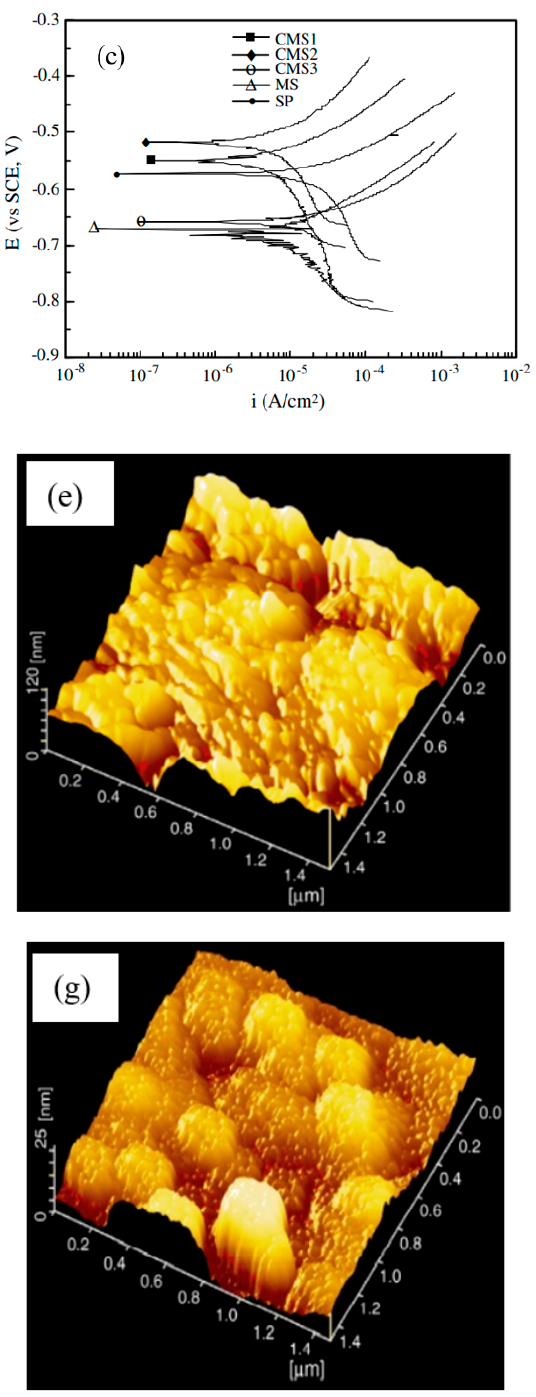
Figure 7. Surface morphology of the sol–gel-coated specimens sintered at ( a ) 400 °C and ( b ) 500 °C [71]. ( c ) PDP plots for the mild steel (MS), the surface pre-treated mild steel (SP) and the sol–gel-coated specimens sintered at 300 °C (CMS1), 400 °C (CMS2) and 500 °C (CMS3) in 3.5% NaCl solution at room temperature [71]. AFM micrographs of coated surface: ( d , e ) conversion-coated mild steel (CcMS) and ( f , g ) alumina-sol-coated steel (Al2O3/CcMS). ( h ) PDP plots recorded at a scan rate of 0.5 mVs − 1 in 3.5 wt% NaCl [72].